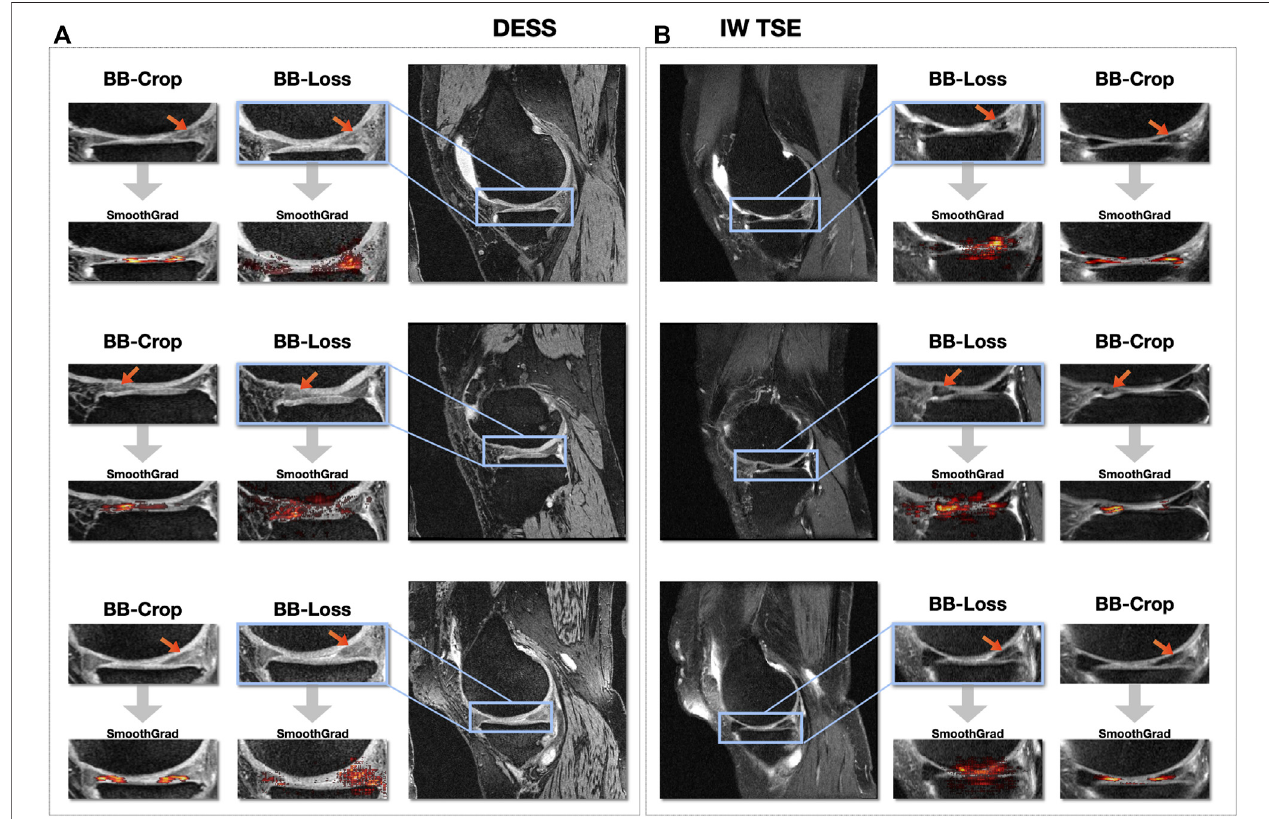
FIGURE 6 | SmoothGrad saliency maps overlaid over DESS MRI data (A) and IW TSE MRI data (B) .